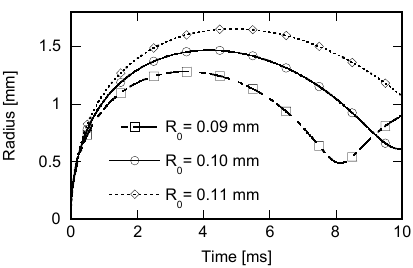
Fig. 9 Influence of initial bubble radius R 0 on the bubble motion with T L 0 = 20 °C and p L ∞ = p vs ( T L 0 ).